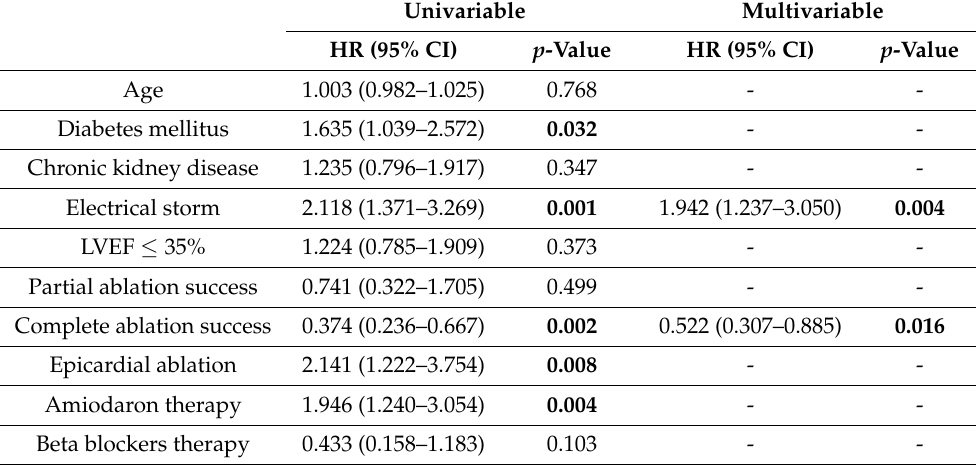
Table 5. Regression model’s VT recurrence all patients.